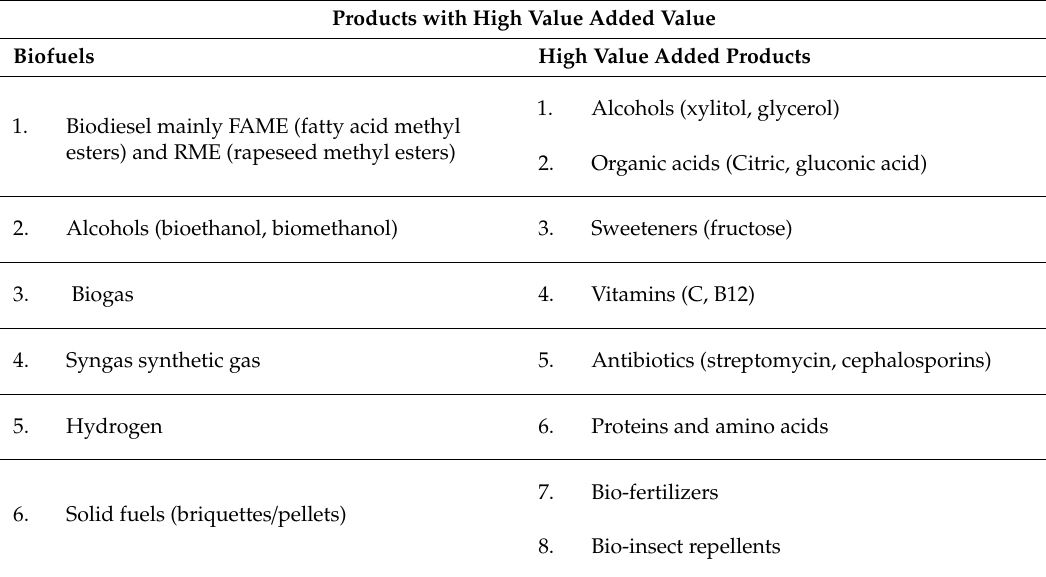
Table 3. High added value products